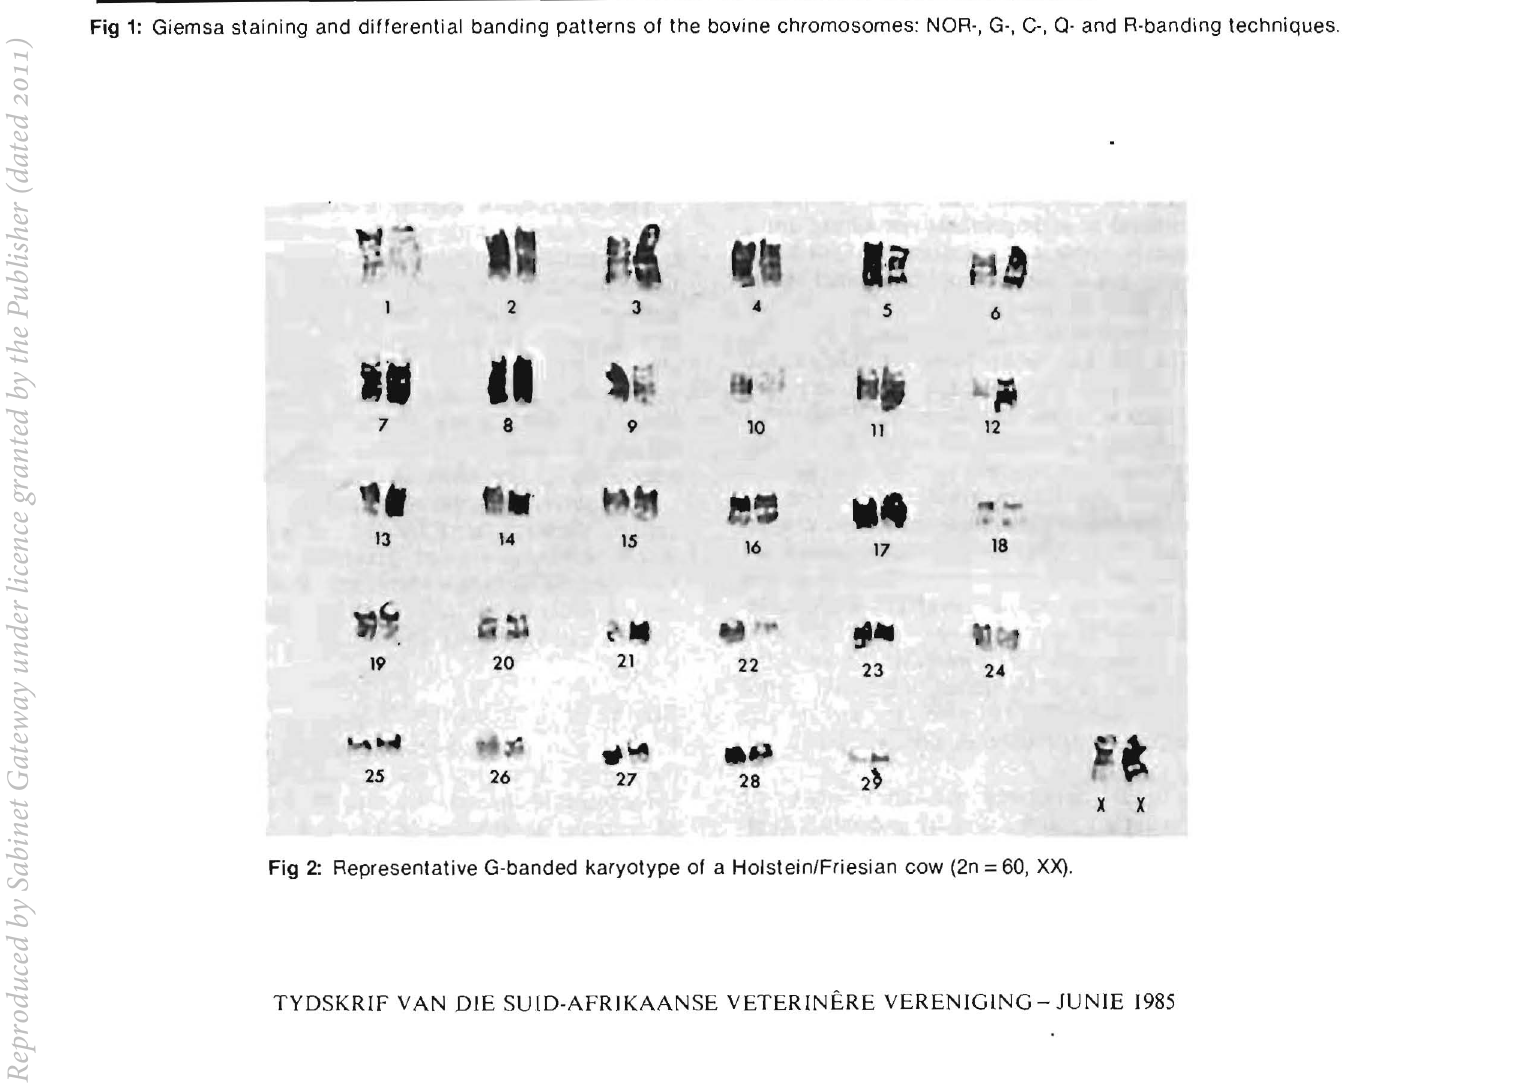
TYDSKRIF VAN DIE SUID-AFRIKAANSE VETERINERE VERENIGING - JUNIE